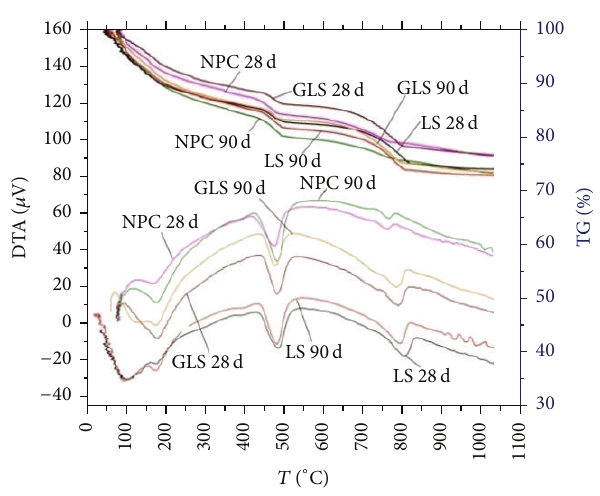
Figure 5: TG-DTA curves of samples.